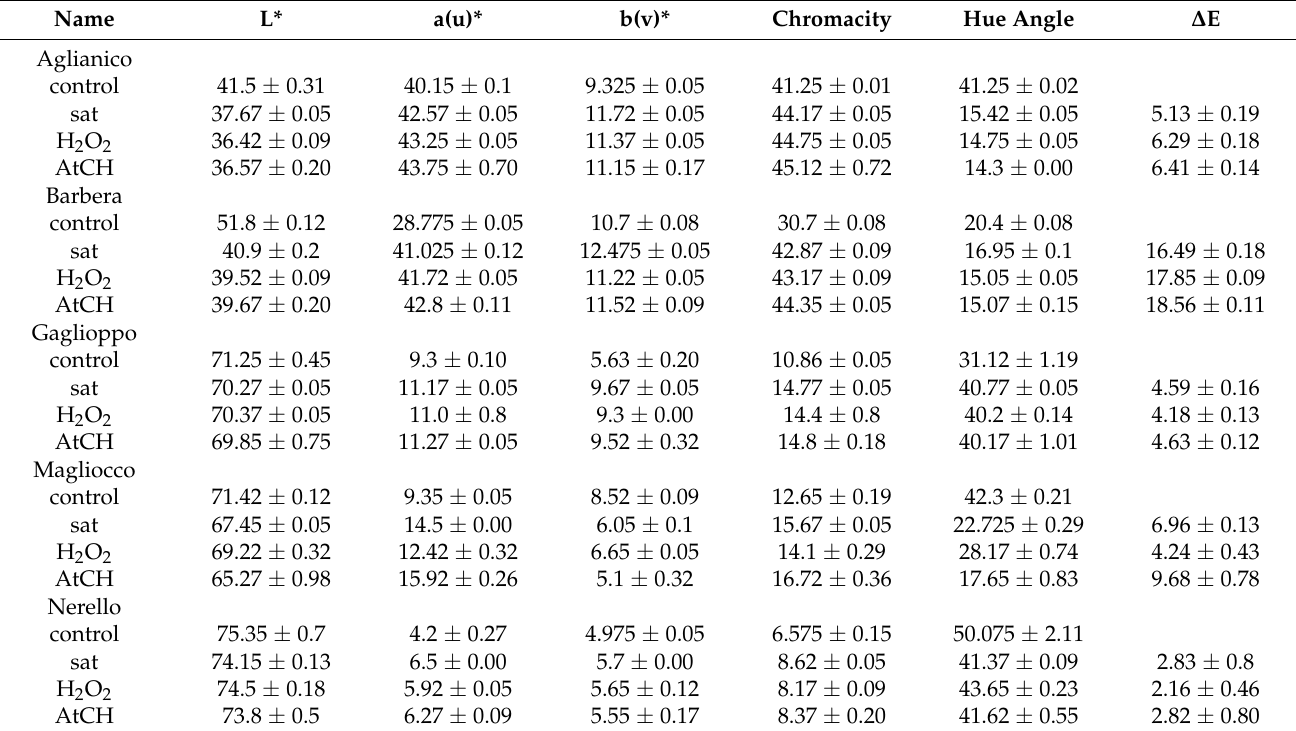
Table 2. Main CIEL*a*b* values of wines in response to oxidative tests